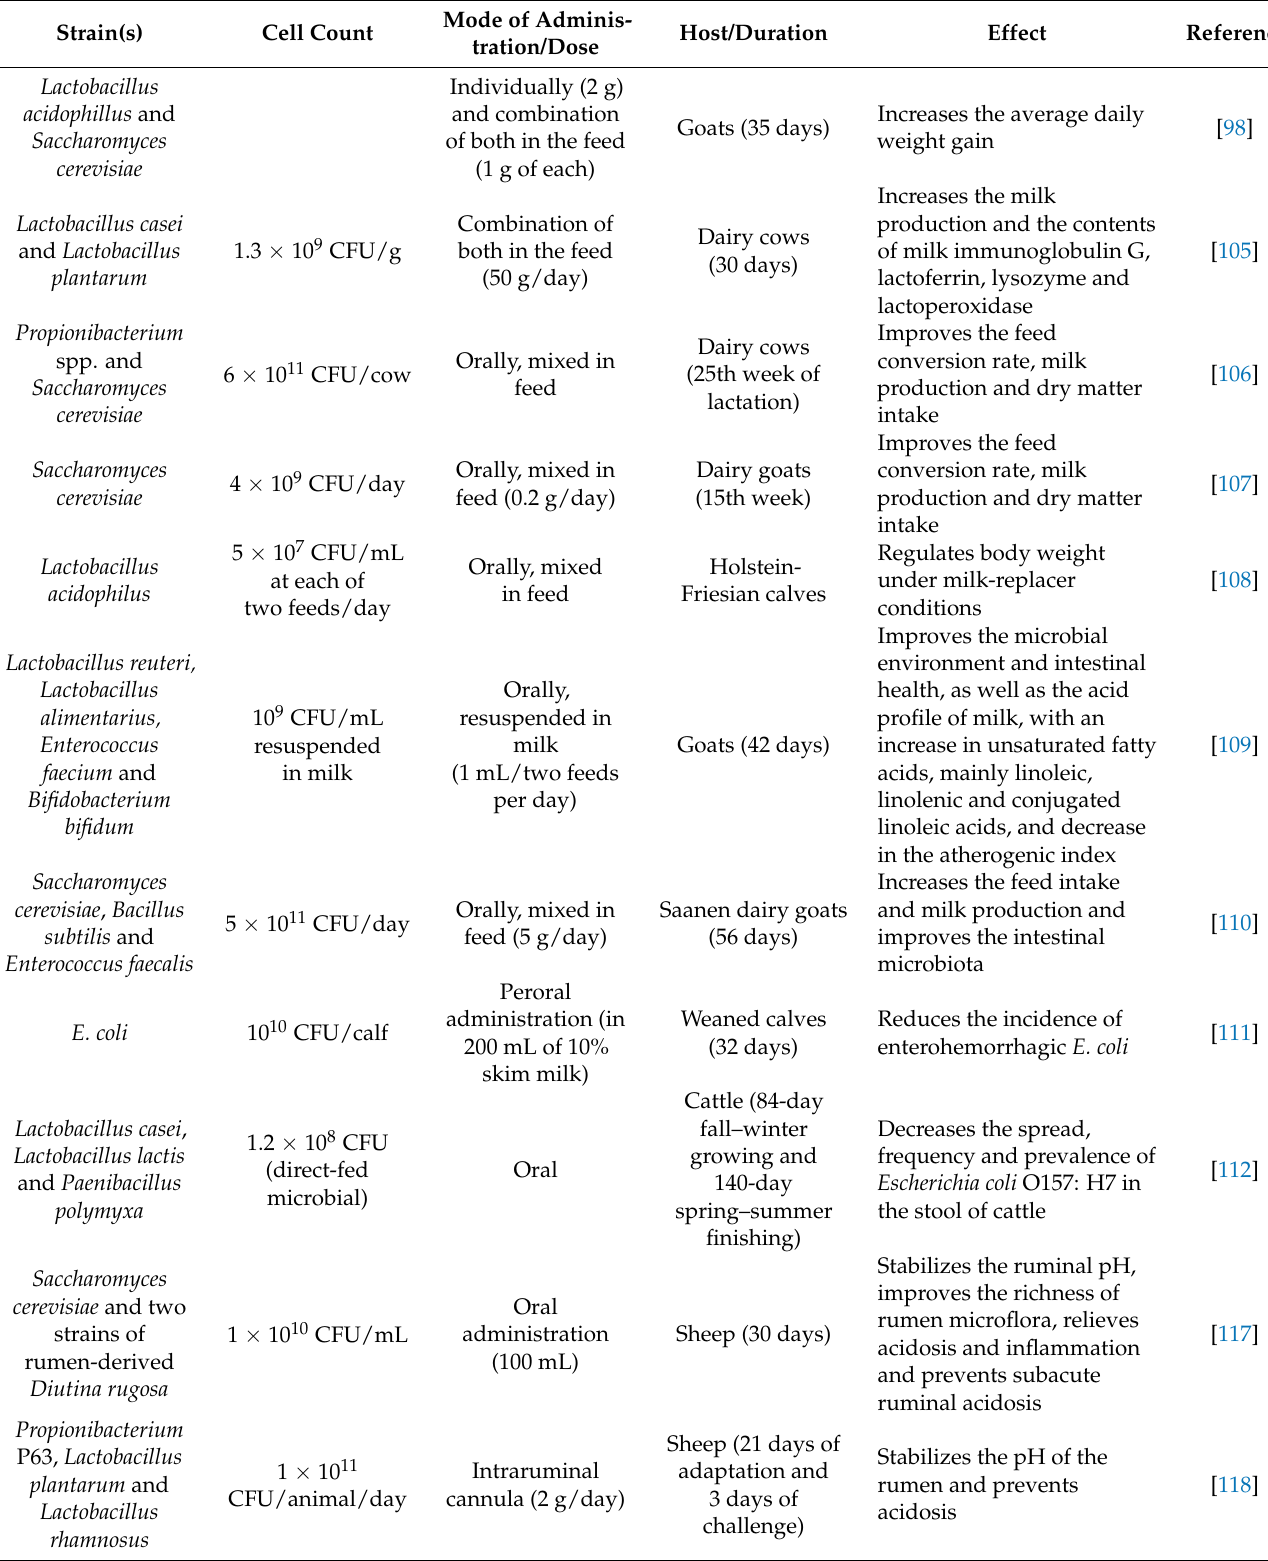
Table 2. Effects of probiotics on ruminant